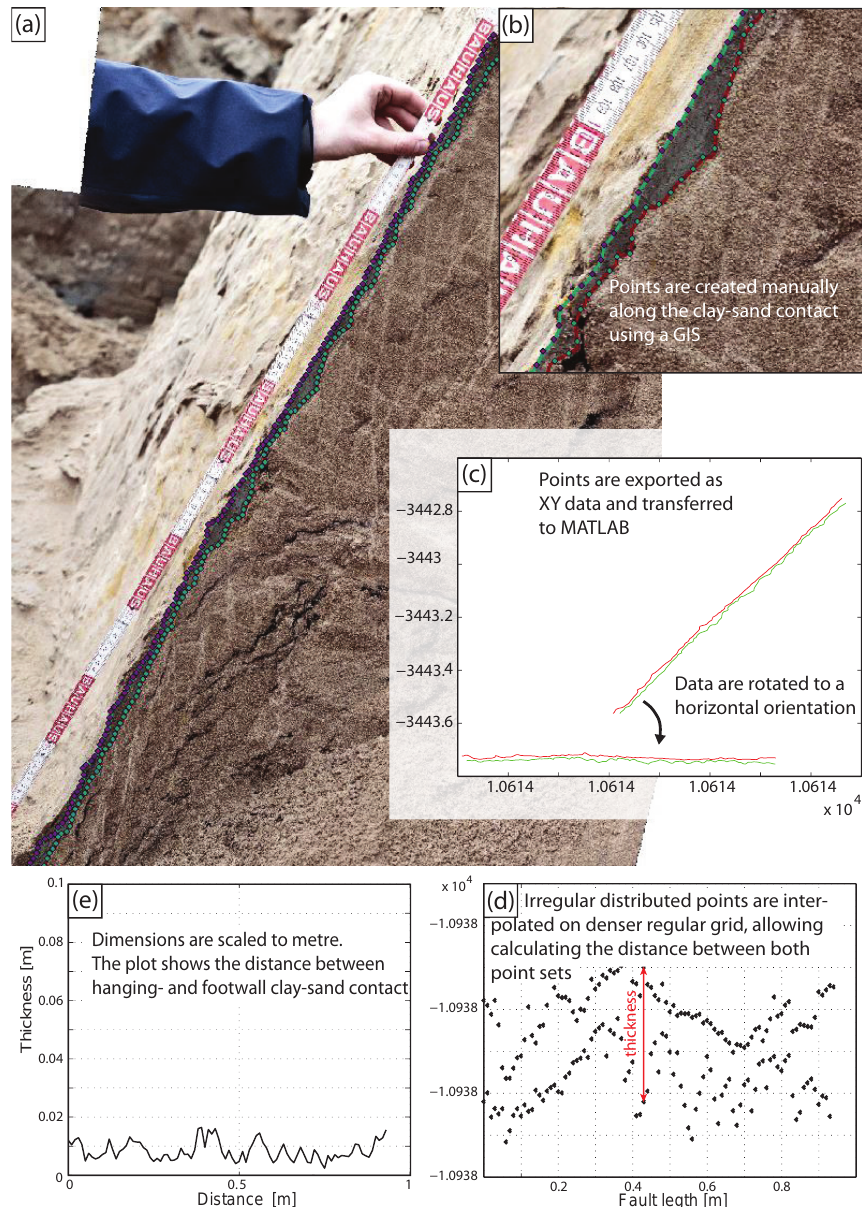
Figure A1. Clay smear thickness is determined from orthogonal field photographs (a) of cleaned cross sections. Clay-sand contacts are manually digitized (b) using GIS software. Data are then transferred to MATLAB (c) and rotated to a horizontal orientation. Scattered data points are interpolated onto a denser grid that allows calculation of the distance between hanging wall and footwall data points (d) . Calculated distances resemble clay smear thickness after a final scaling (e) . The plot shows clay smear thickness along the